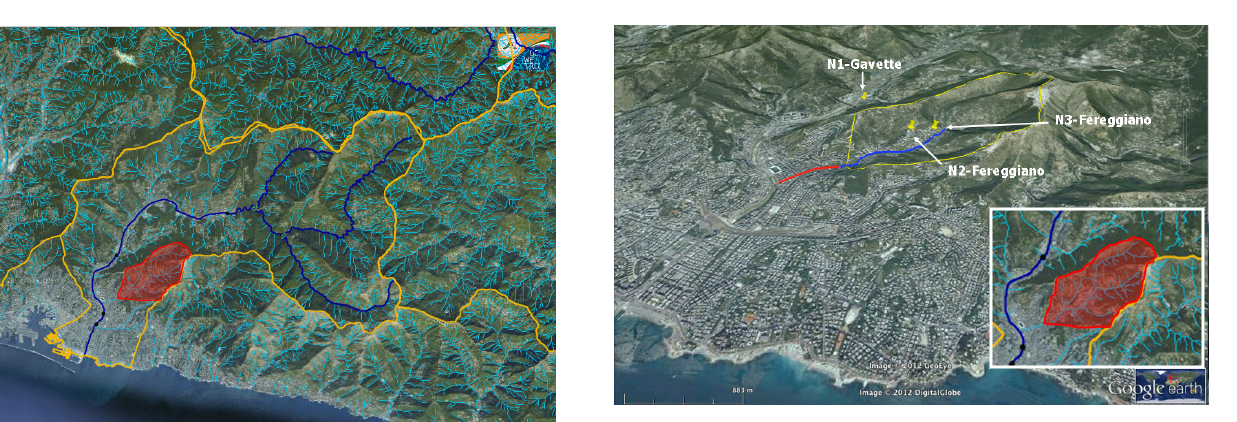
Figure 6. Location of the three analyzed rain gauges: the blue and red line shows the Fereggiano riverbed, in red the covered reach. The yellow line is the watershed divide. On the bottom right corner the Fereggiano watershed is shown together with its drainage network.